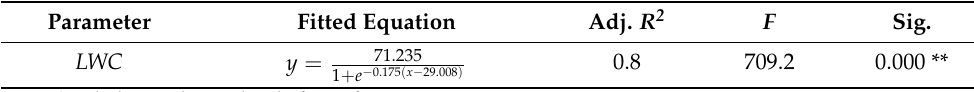
Table 4. Curve-fitting of leaf water content of spring wheat under rapid-drought stress.